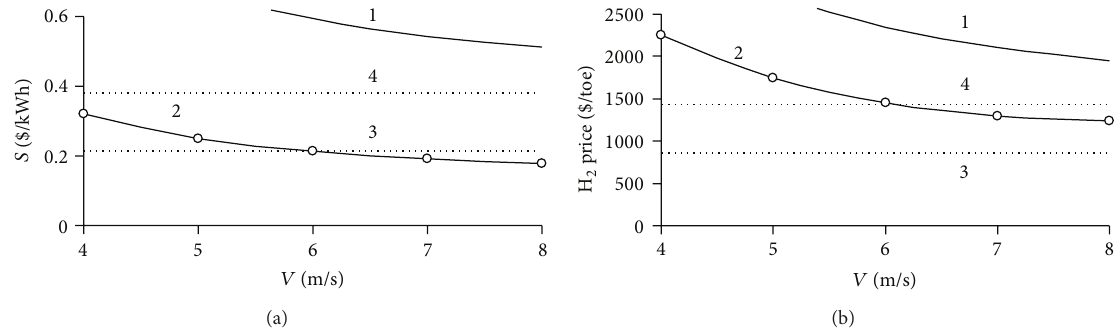
Figure 6: Cost of electricity generated by fuel cells (a) and cost of hydrogen supplied from the hydrogen tank (b) for the scheme in Figure 2: 1: current indices of the system components; 2: prospective indices; 3: electricity from diesel generator at a fuel price of $800/toe (a) and fuel price of $800/toe (b); 4: the same, fuel price is $1400/toe.